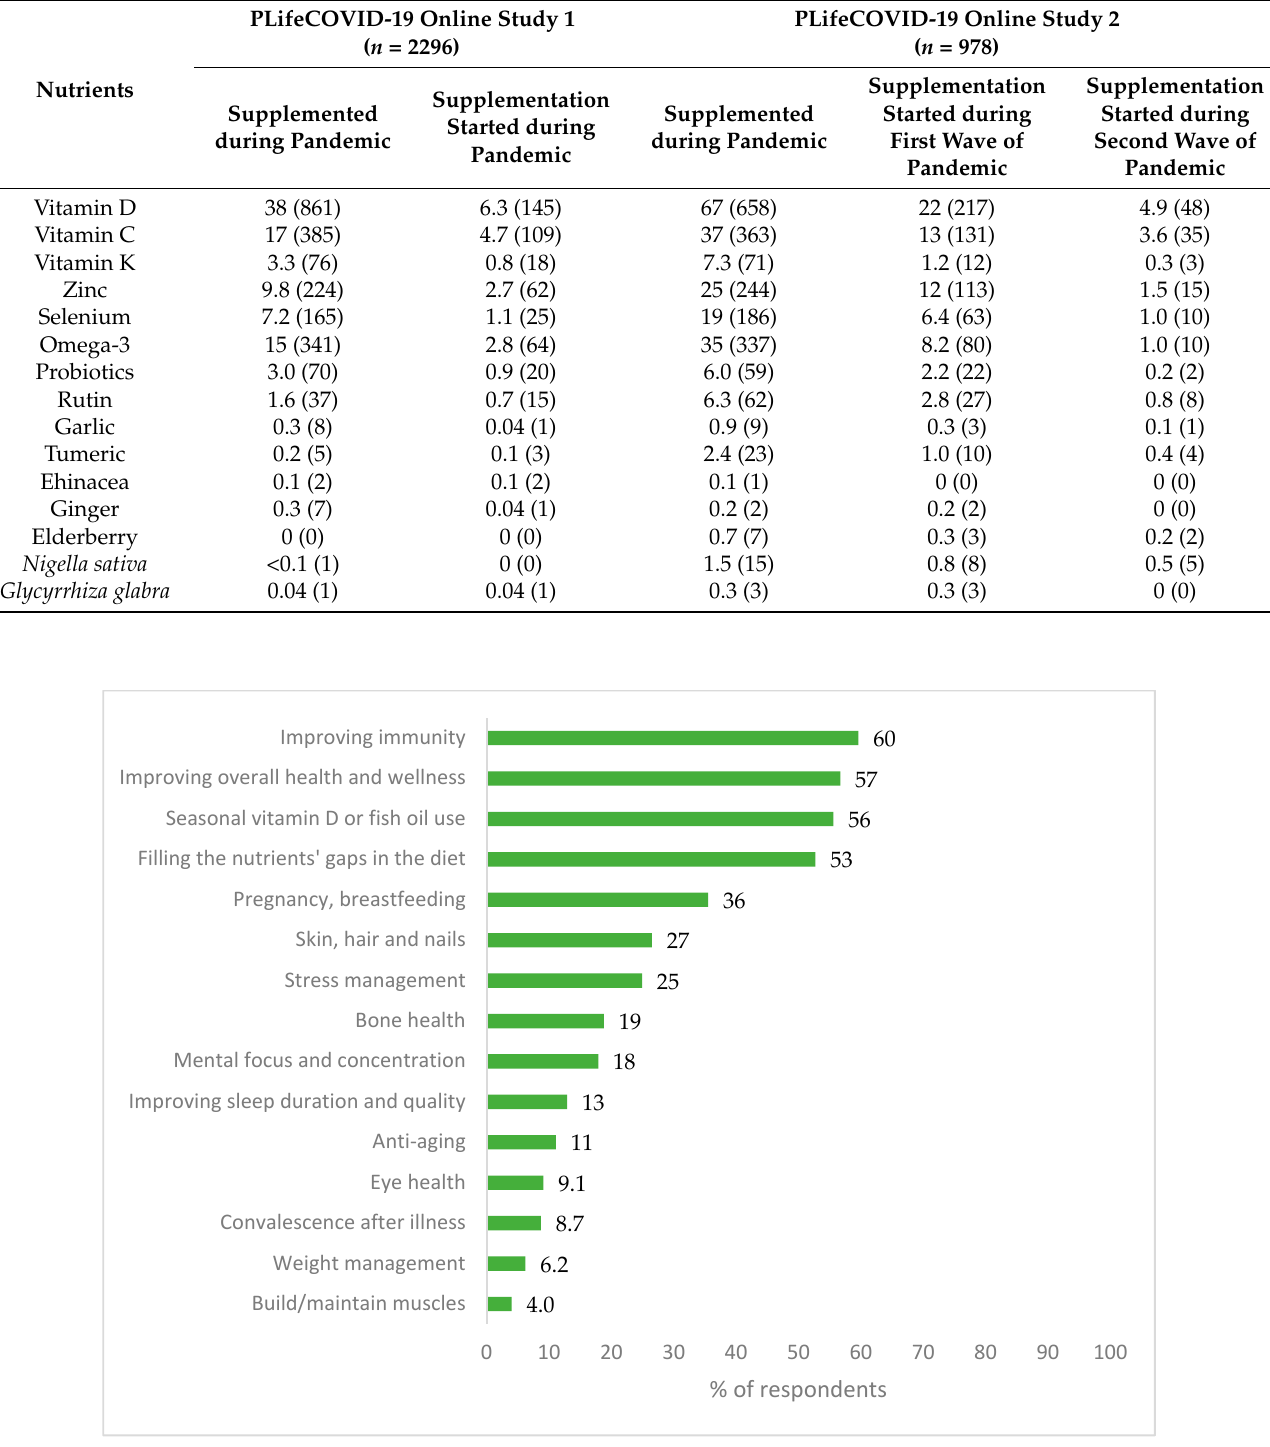
Figure 4. Reasons for the usage of dietary supplements—results of the PLifeCOVID-19 Online Study 2 ( n = 978).